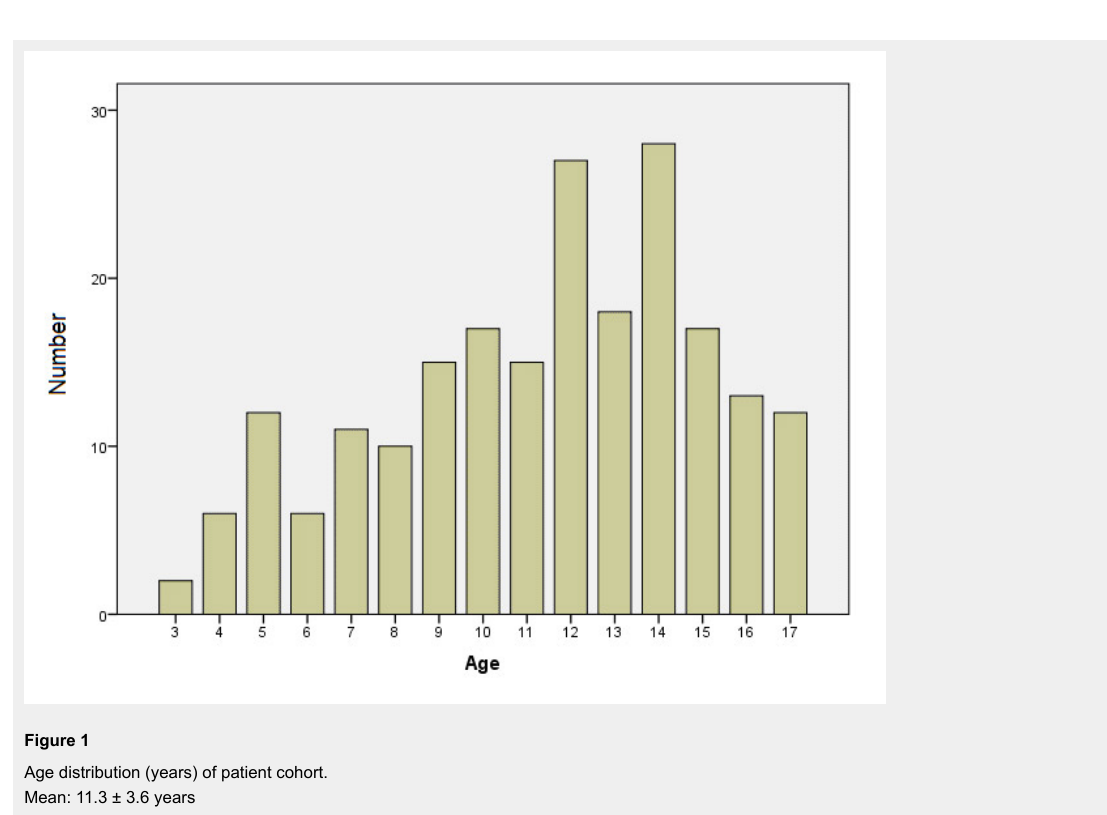
Age distribution (years) of patient cohort. Mean: 11.3 ± 3.6 years